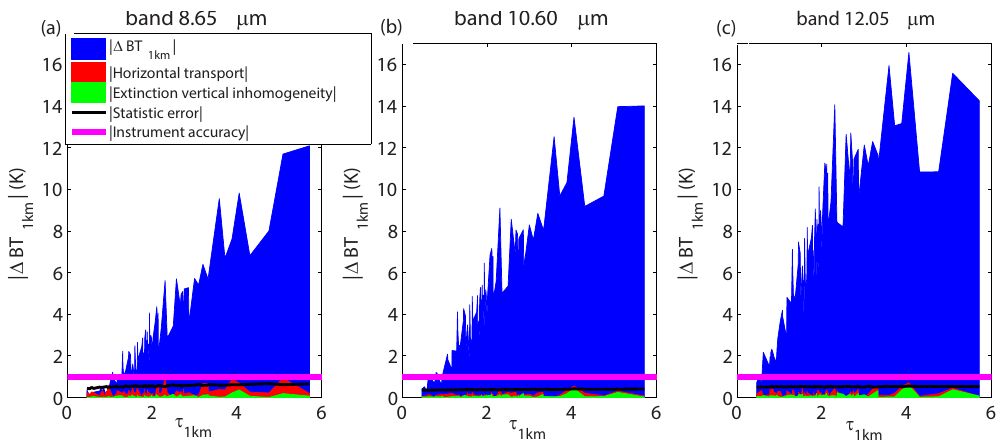
Figure 10. Absolute brightness temperature differences at 1km × 1km 1 BT 1km (in blue) due to the horizontal transport (in red), the extinction vertical variability (in green), the statistical error of the code (black line) and the IIR instrumental accuracy (pink line) for cirrus 5. Results are presented for the bands at 8.65µm, 10.60µm and 12.05µm.